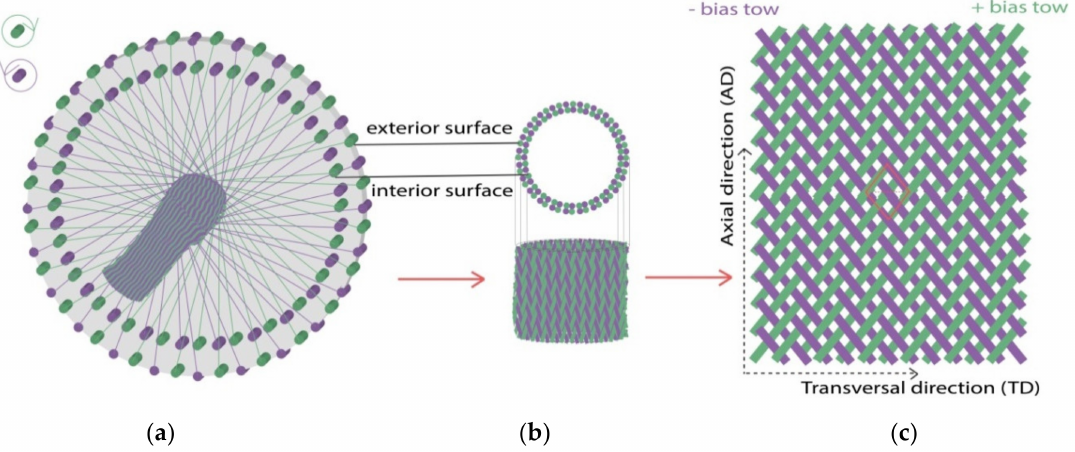
Figure 1. 2D biaxial braids from macro-scale to meso-scale: ( a ) integral braids from loom; ( b ) circular braids part and ( c ) opened one-layer braided